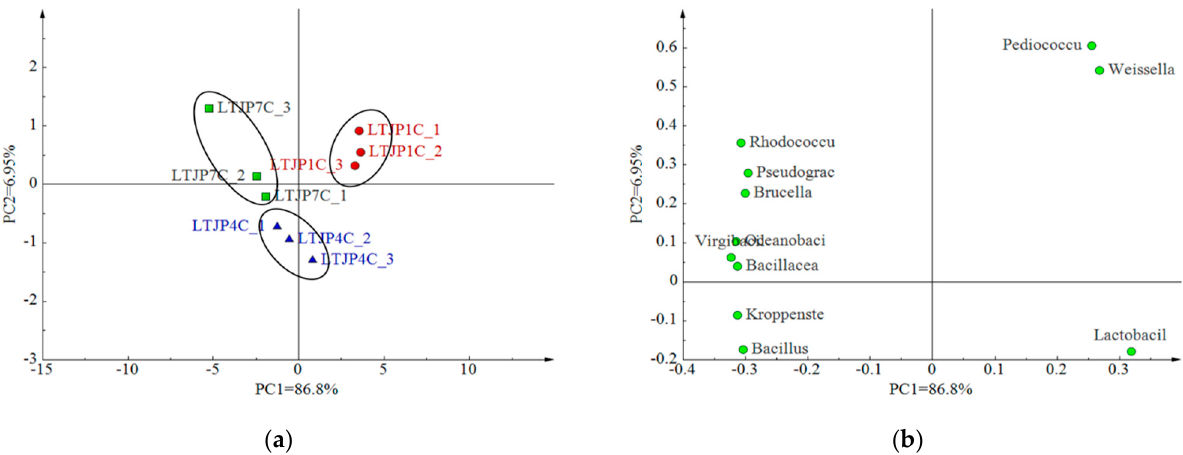
Figure 2. Principal component analysis (PCA) of bacterial communities and samples during baijiu fermentation. ( a ) Principal component analyses of samples during baijiu fermentation; ( b ) Loading plot for all bacterial communities during baijiu fermentation.